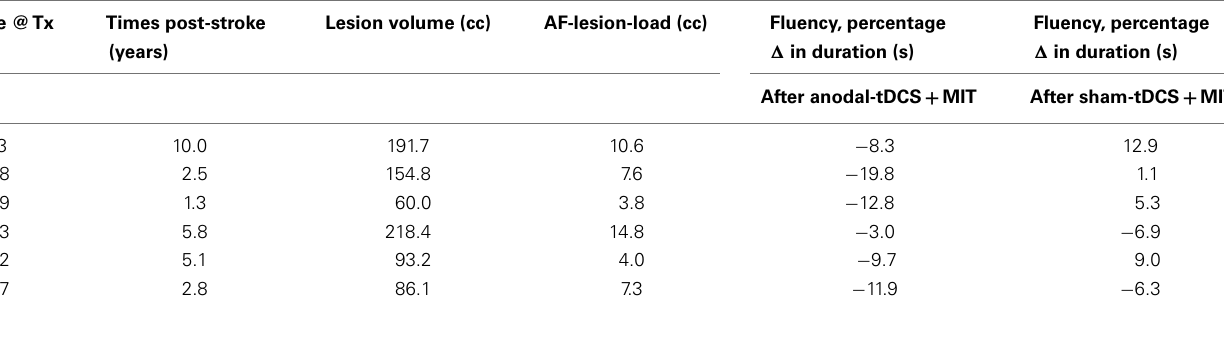
Table 1 |Age at treatment (in years), time post-stroke (in years), total lesion volume (in cubic centimeter), lesion volume overlying a canonical arcuate fasciculus derived from a group of healthy elderly control subjects (AF lesion-load; for more details see Marchina et al., 2011), and fluency changes (in seconds) either after three sessions of anodal-tDCS + MIT or after three sessions of sham-tDCS +